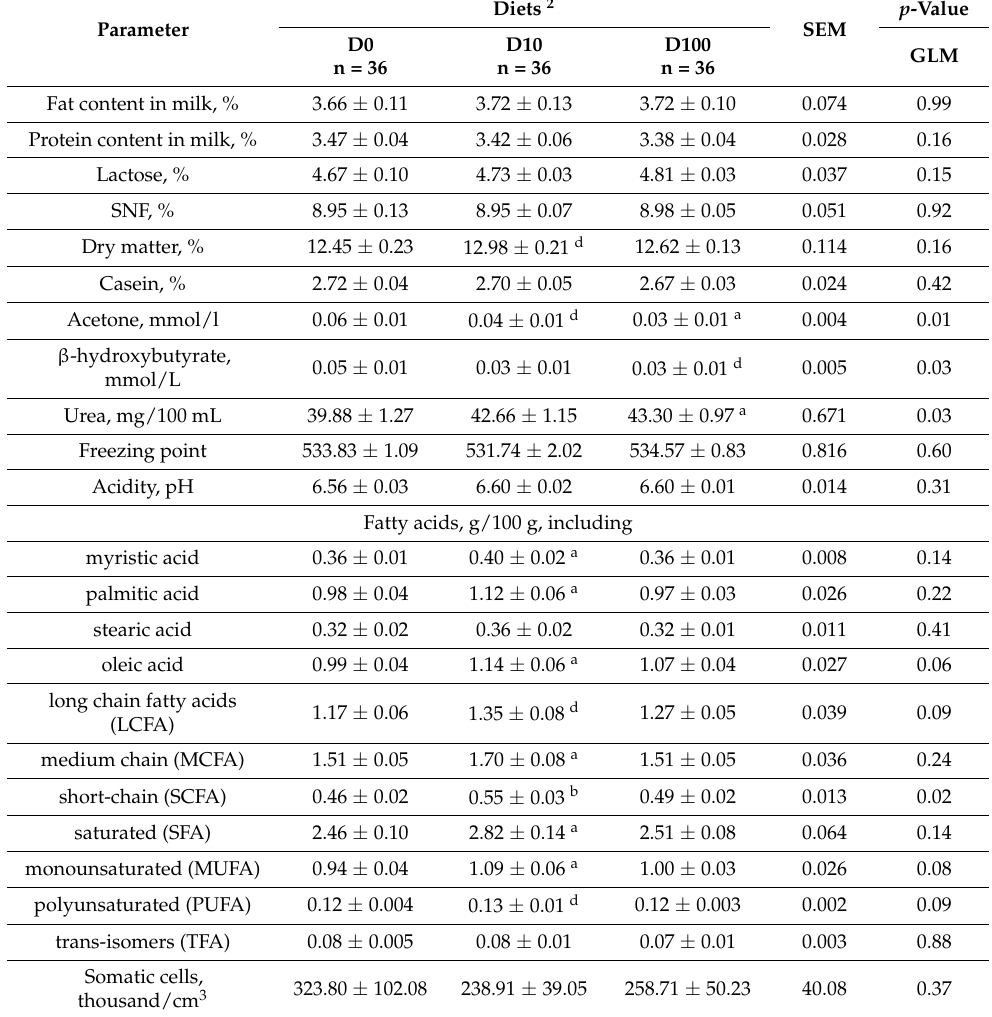
Table 6. Indicators of average composition and quality of milk for the experimental period 1